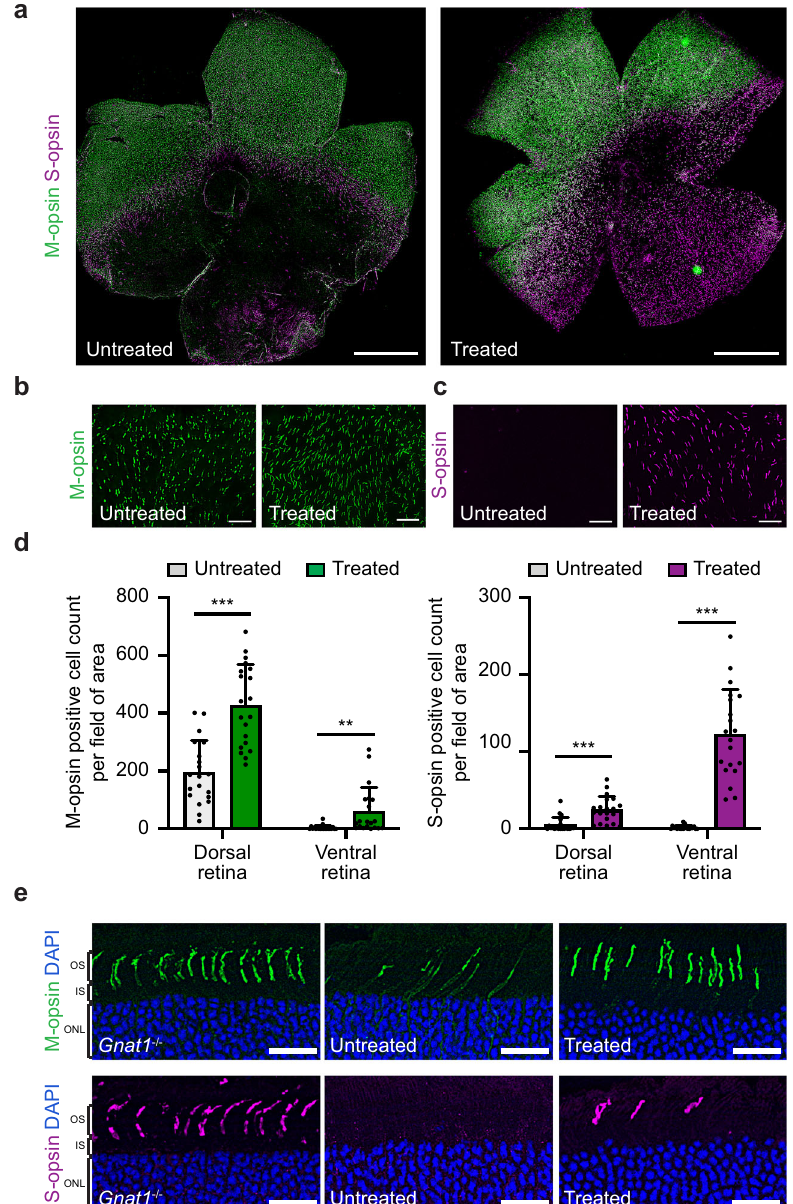
Fig. 5 Protection of cone photoreceptors and correct opsin localization in 2-month-old rd12Gnat1 − / − following ABE treatment. a Representative retinal fl atmounts from untreated (left) and treated (right) rd12Gnat1 − / − mouse eyes, labeled with M-opsin (green) and S-opsin (purple) antibodies. Scale bar, 1 mm. b Magni fi ed view of M-cones (green) in the dorsal retina from untreated and treated rd12Gnat1 − / − mice. Scale bar, 50 μ m. c Magni fi ed view of S-cones (purple) in the ventral retina from untreated and treated rd12Gnat1 − / − mice. Scale bar, 50 μ m. d Quanti fi cation of M-cones and S-cones in each fi eld as shown in b , c , at dorsal and ventral regions of the retina, 1 mm away from the optic nerve. Five fi elds across the dorsal or ventral retina were analyzed from each eye, with a total of 20 fi elds from 4 eyes per group. Mea ± SD. ** P < 0.01; *** P < 0.001; unpaired t -test, two-tailed. P values for dorsal and ventral M-cones and dorsal and ventral S-cones are 0.000001, 0.006, 0.00009, and <0.000001, respectively. e Retinal cryosections from Gnat1 − / − , and untreated and treated rd12Gnat1 − / − mice, showing the dorsal region labeled with M-opsin (top) and the ventral region labeled with S-opsin (bottom). DAPI, blue; OS outer segment, IS inner segment, ONL outer nuclear layer. Scale bar, 20 μ m. Source data are provided as a Source data fi 6 months of age (Supplementary Fig. 7a, b). On retinal fl atmounts from the treated eyes, both S-cones and M-cones were still detected at 6 months of age (Supplementary Fig. 7c, d). Cone quanti fi cation showed a signi fi cantly higher number of both M-cones and S-cones in the aged treated eyes, suggesting that base editing is able to prolong cone survival in the long-term ( n = 3 per group) (Supplementary Fig. 7e).